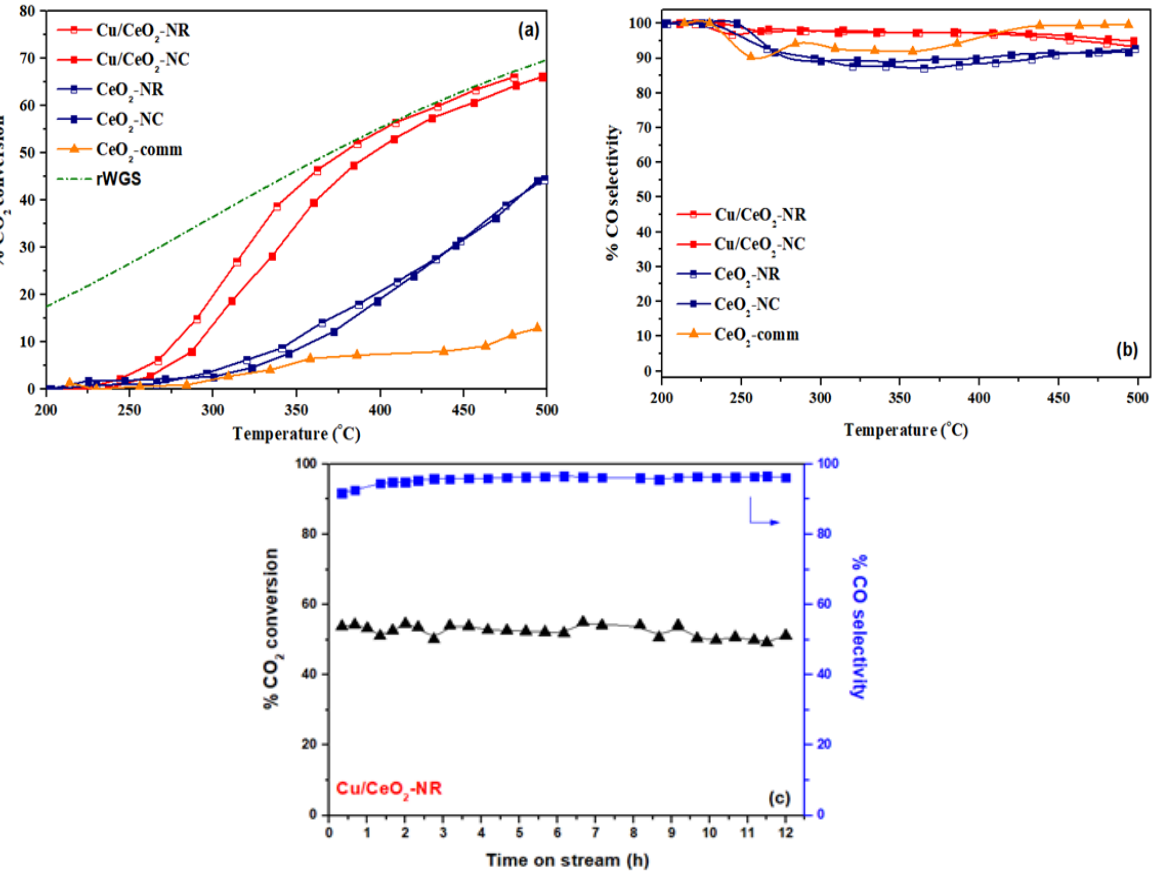
Figure 24. Values of CO 2 conversion ( a ) and CO selectivity ( b ) as a function of temperature and time on stream ( c ) for Cu/CeO 2 catalysts with variable ceria nanomorphology (NR: nanorods, NC: nanocubes). Adapted from Ref. [150]. Copyright© 2019, MDPI.